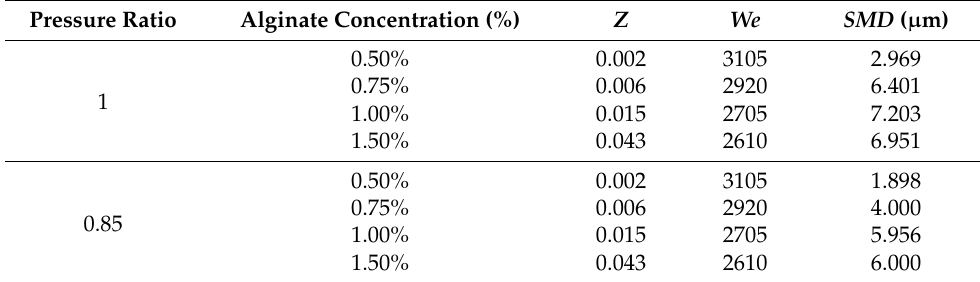
Table 6. Dimensionless numbers for each experiment and their particle size